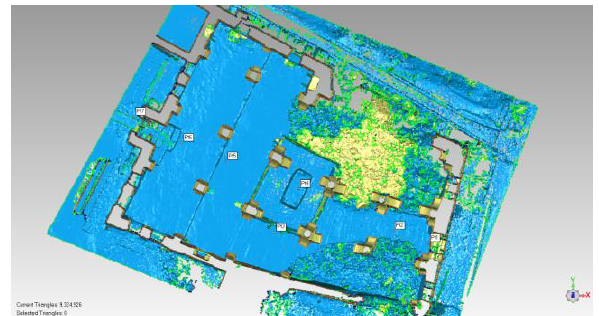
Figure 3. Orthogonal data projection of the shrine from the Faro